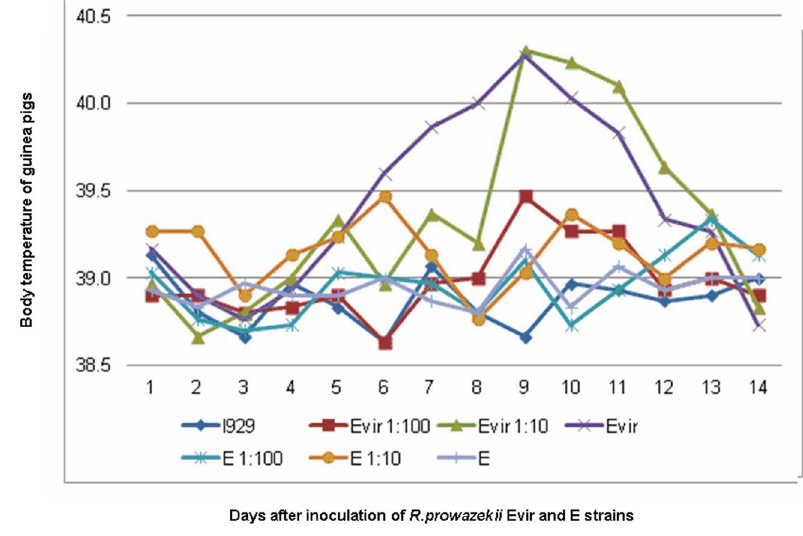
Figure 2. Body temperature changes after infection with R.prowazekii strain E (DHW) and strain Evir at 10 6 (E or Evir), 10 5 (E1:10 and Evir 1:10), or 10 4 (E1:100 and Evir 1:100) organisms. L929 cell suspension was used as